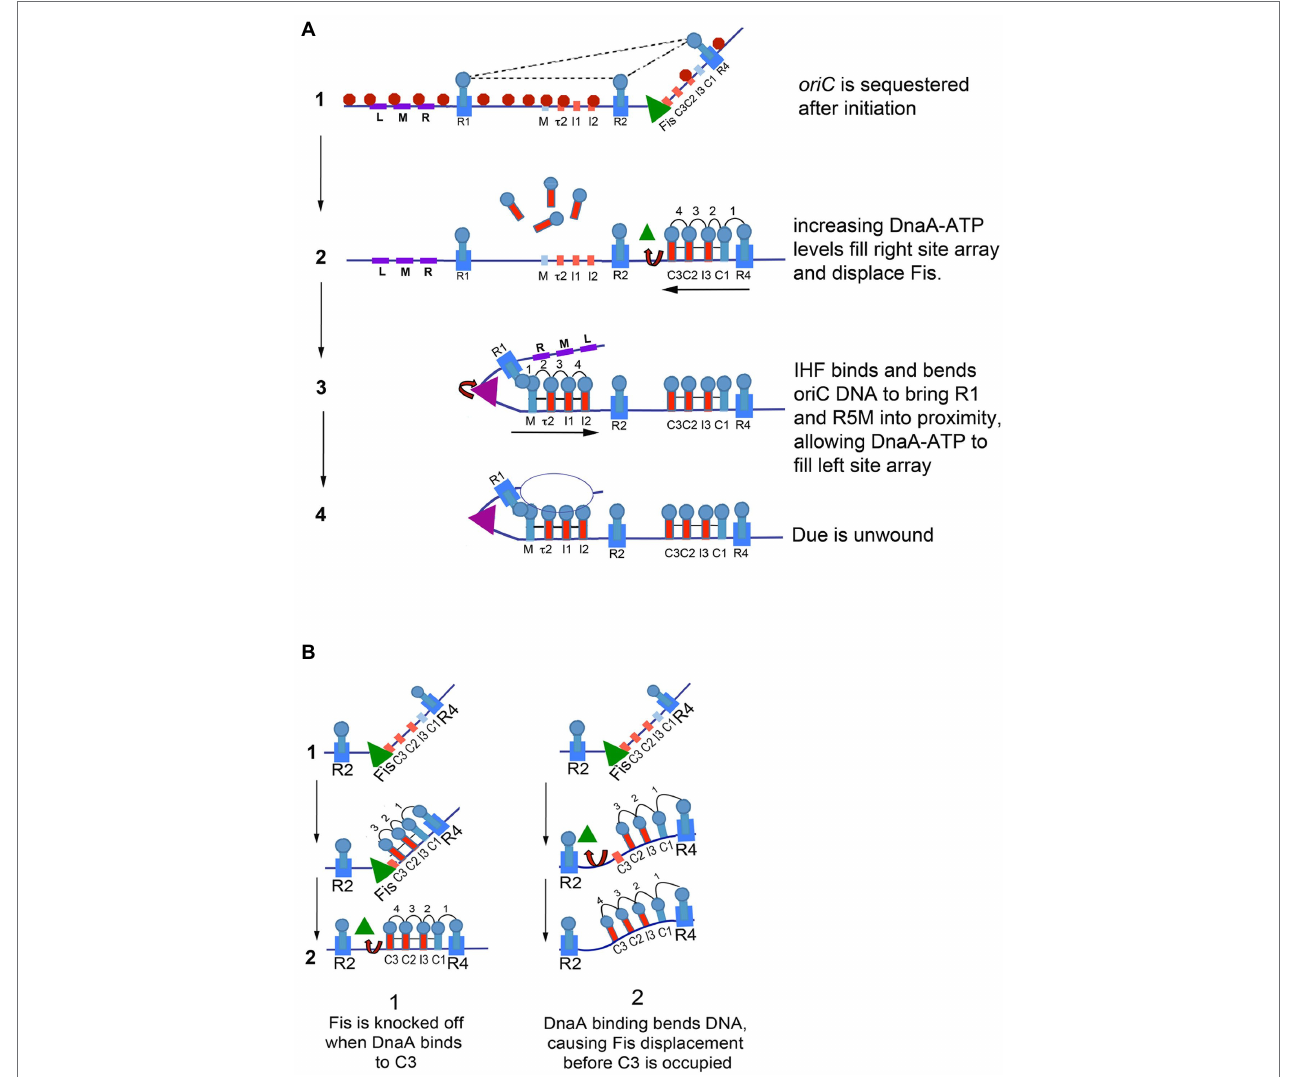
FIGURE 2 | (A) Model of staged E. coli orisome assembly. Stage1: After oriC is replicated, SeqA (red octagons) binds to hemimethylated 5 ′ -GATC motifs, and DnaA rebinds to high affinity R1, R2, and R4 sites. Fis (green triangle) is also bound. DnaA and Fis binding constrains the origin, possibly through interactions among the bound DnaA molecules (indicated by dotted lines), and prevents IHF from binding to its recognition site. Stage 2: DnaA bound to R4 recruits DnaA for binding to C1. DnaA-ATP then progressively fills the remaining sites in the right array. DnaA displaces Fis, and loss of Fis allows IHF to bind. Stage 3: The IHF-induced bend allows DnaA cooperative binding of DnaA between R1 and R5M. DnaA then progressively fills the remaining sites in the left array. Stage 4: The DUE is unwound and one of the single strands interacts with DnaA-ATP bound to the left array. The figure is adapted from Leonard and Grimwade (2015). (B) Possible mechanisms of Fis displacement by DnaA. When sufficient levels of DnaA accumulate, Fis is displaced either by direct competition with DnaA binding to C3 (left panel) or by a conformation change caused by DnaA binding to the right low affinity sites in oriC (right